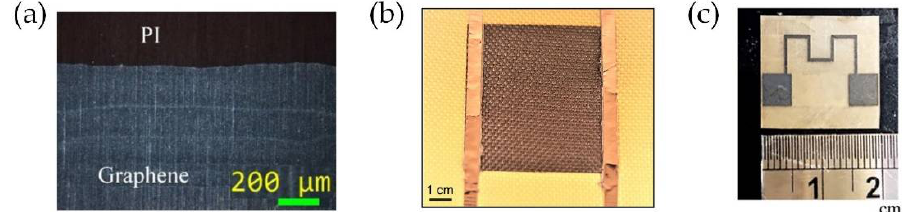
Figure 1. Structures of microheaters based on graphene fabricated with ( a ) inkjet-printed method [21], ( b ) laser-induced method [22], and ( c ) ultrafast laser ablation method [23]. Reprinted with permission from MDPI, ACS, and ELSEVIER.